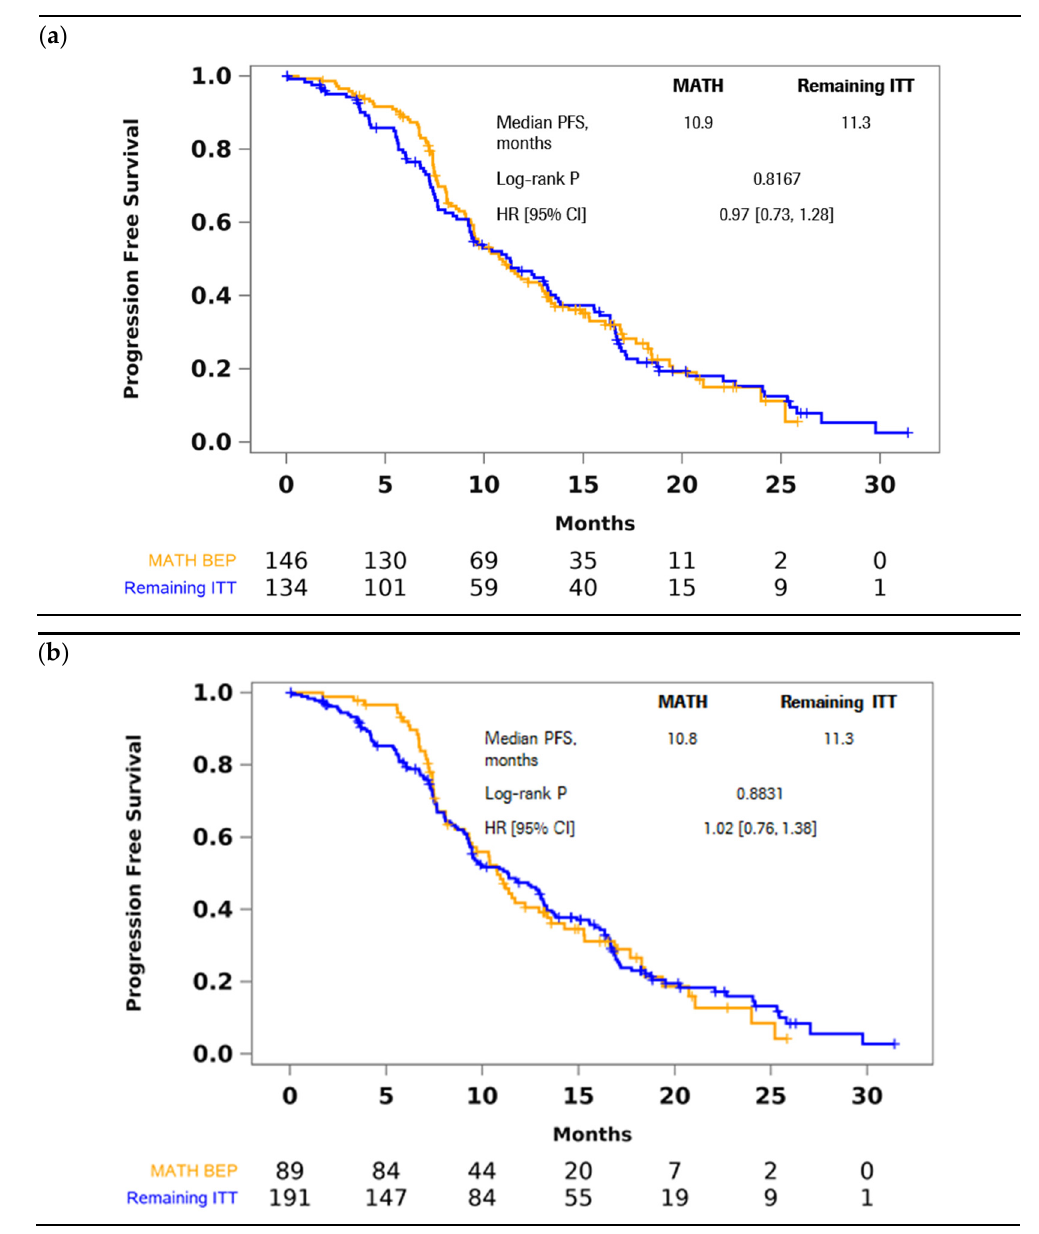
( f ) Figure A3. Correlation between MATH and mean AF or mean MMPM or number of somatic muta- tions . Correlation between pre-induction MATH and mean AF ( a ) Spearman rho = 0.542), mean MMPM; ( b ) Spearman rho = 0.595), or number of somatic mutations; ( c ) Spearman rho = 0.536). Correlation between post-induction MATH and mean AF; ( d ) Spearman rho = 0.493), mean MMPM; ( e ) Spearman rho = 0.489), or number of somatic mutations; ( f ) Spearman rho = 0.809).